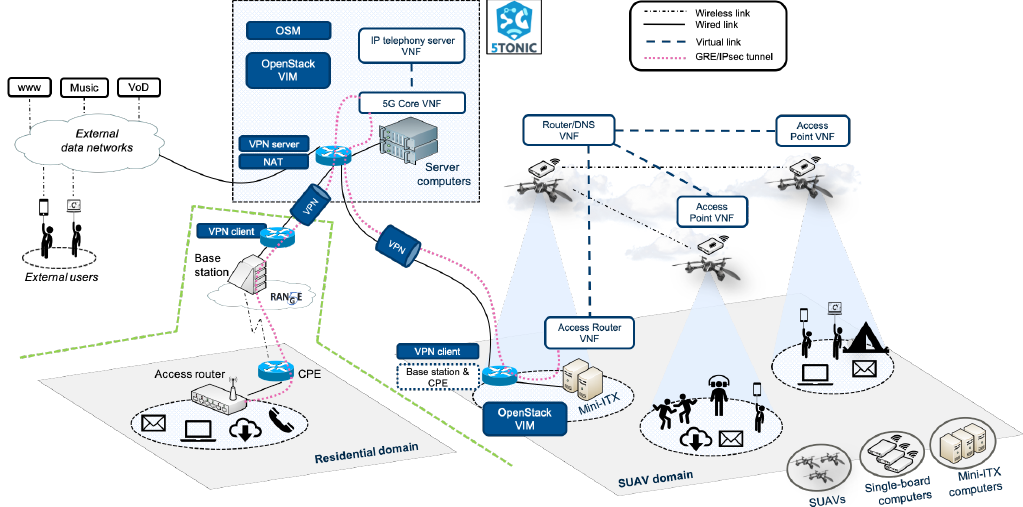
Figure 1. Overview of the testbed components and the experimentation